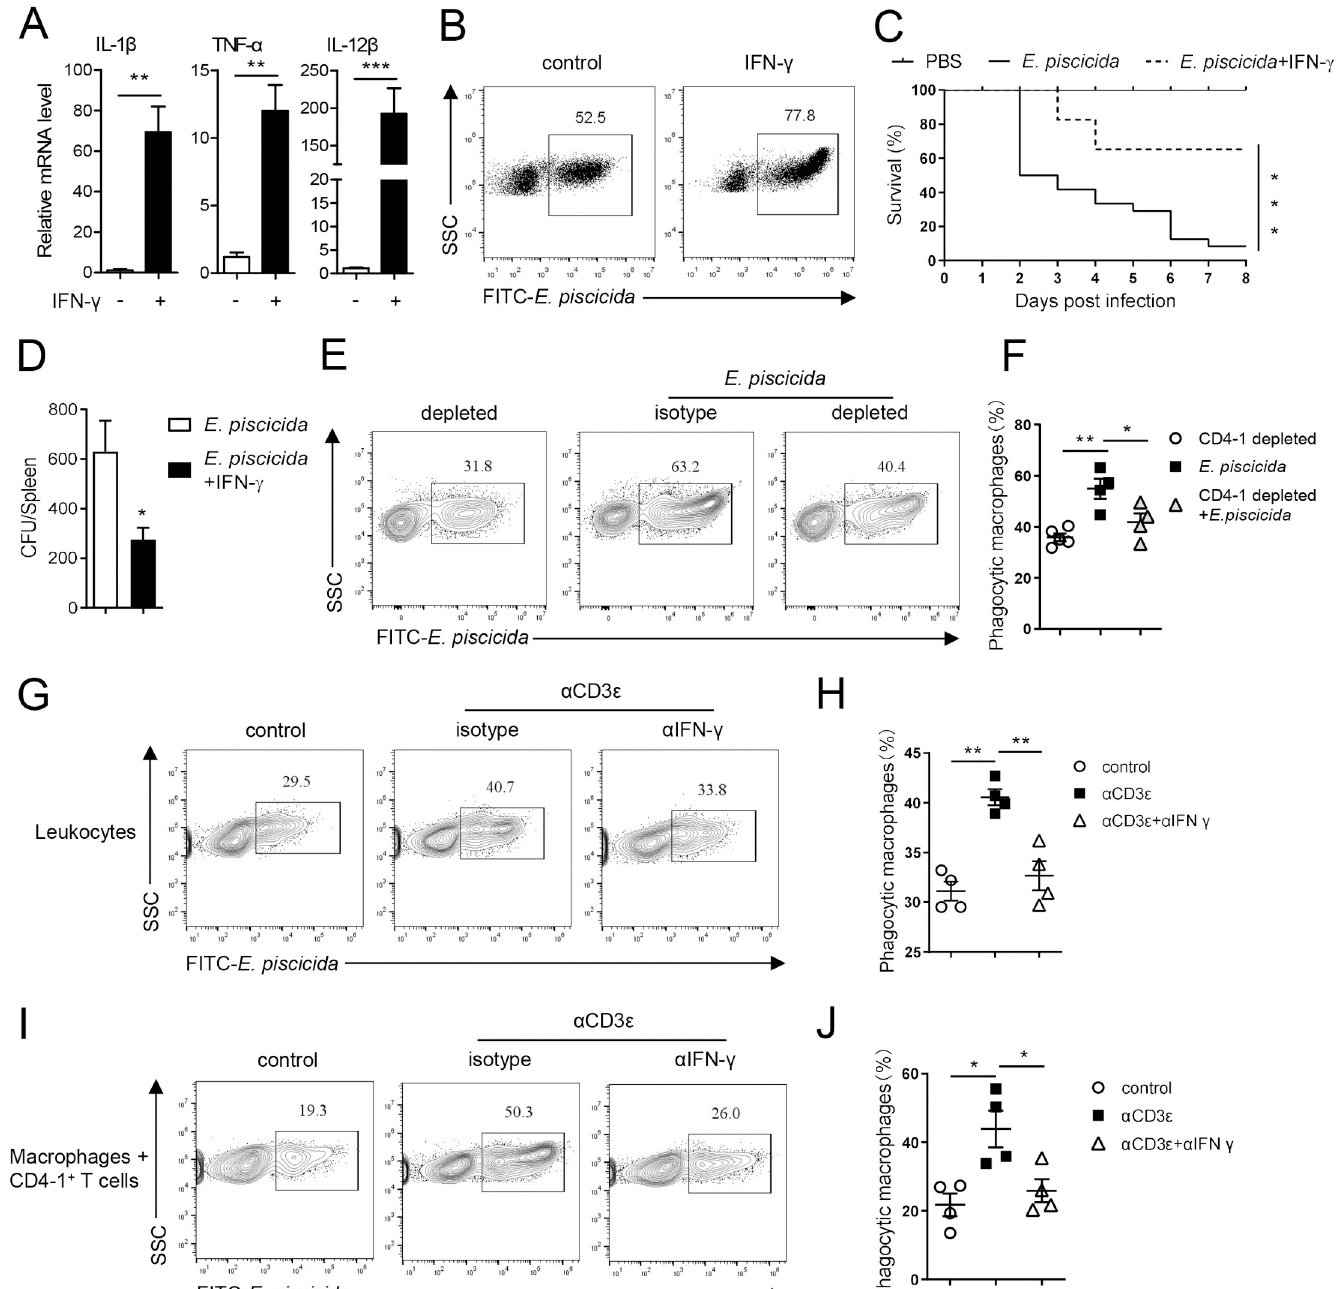
Fig 4. Th1 cells activate macrophages to facilitate anti-bacterial immune response in tilapia. ( A ) Head kidney macrophages were stimulated with recombinant IFN- γ protein, and relative mRNA levels of indicated molecules were examined at 12 h post stimulation by qPCR, n = 4–6. ( B ) Dot plots showed the phagocytic rates of head kidney macrophages against FITC-labelled E . piscicida in the presence or absence of recombinant IFN- γ . ( C, D ) Tilapia individuals that infected with E . piscicida were injected with recombinant IFN- γ or PBS. ( C ) Kaplan-Meyer survival plot showed the survival percentage of tilapia, n = 25. ( D ) E . piscicida titers in spleen on 5 DPI, n = 6. ( E, F ) CD4-1 + cells were depleted as described in Fig 3F. Tilapia individuals were infected with E . piscicida on day 9 after depletion, and head kidney leukocytes were harvested on 5 DPI for assay. The flow cytometry ( E ) and scatter plot figures ( F ) showed the phagocytosis of macrophages from CD4-1-depleted or nondepleted tilapia against FITC-labelled E . piscicida at 12 h, n = 4–5. ( G, H ) The head kidney leukocytes that stimulated with CD3 ε mAb or not in the presence of IFN- γ mAb or isotype antibody were incubated with FITC-labelled E . piscicida . The flow cytometry ( G ) and scatter plot figures ( H ) showed the phagocytosis of macrophages at 12 h, n = 4. ( I, J ) The head kidney macrophages and CD3 + CD4-1 + T cells that sorted from the same tilapia individual were co-cultured with or without CD3 ε mAb, IFN- γ mAb and FITC-labelled E . piscicida . The flow cytometry ( I ) and scatter plot figures ( J ) showed the phagocytosis of macrophages at 12 h, n = 4. These experiments were repeated for at least two independent times. � : p < 0.05, �� : p < 0.01, ��� : p < 0.001, determined by a two-tailed Student’s t-test.